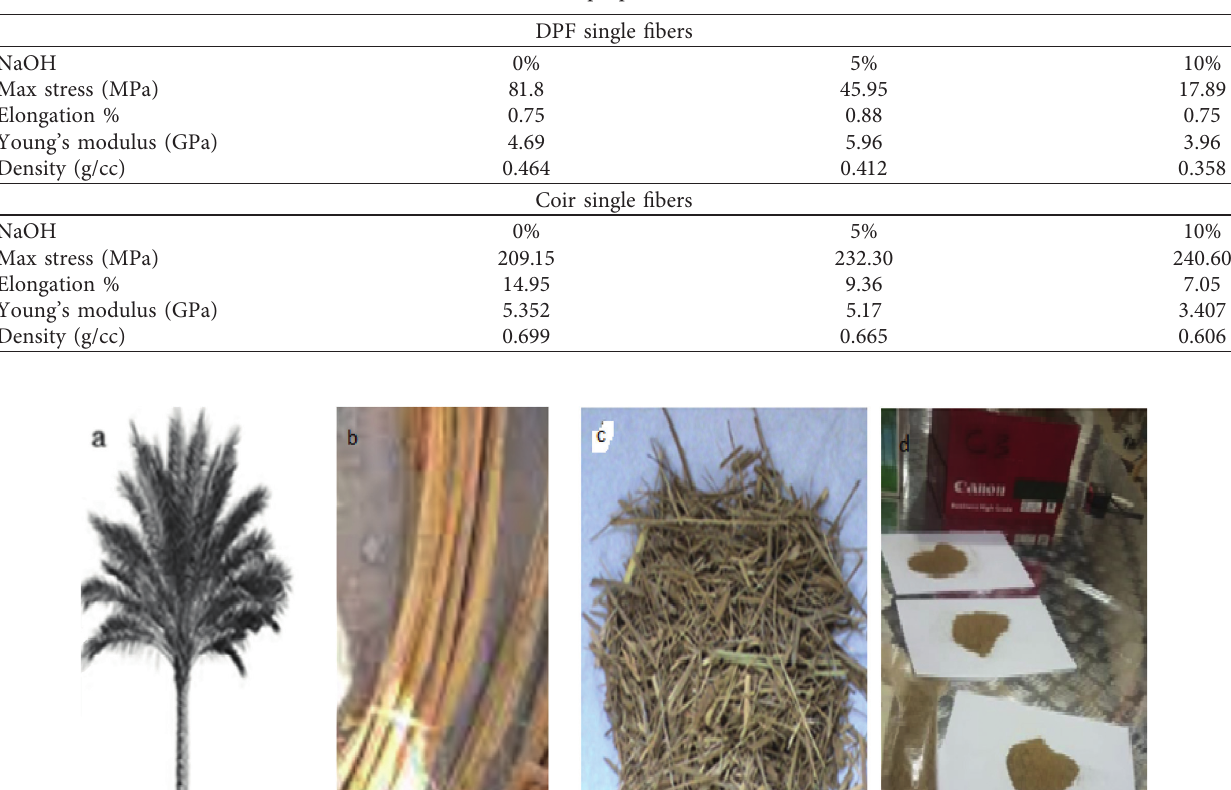
Table 1: Mechanical properties of natural